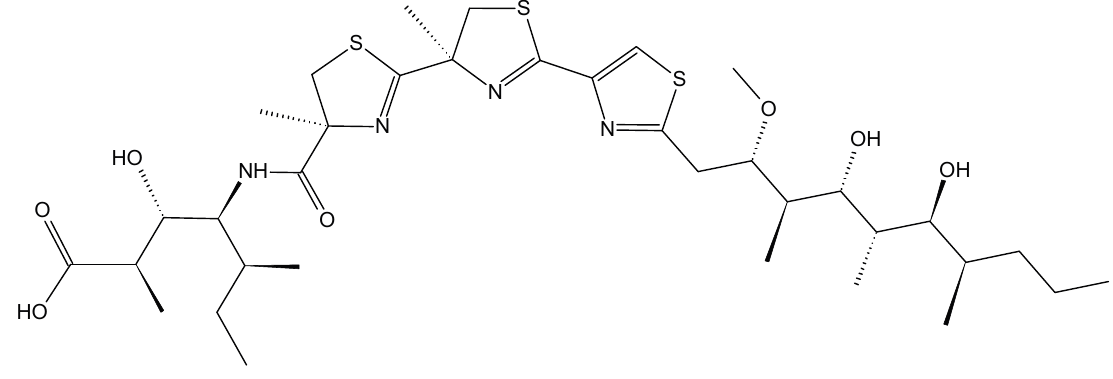
Figure 21. Structures of the carboxylate and acid forms of hoiamide D ( 59